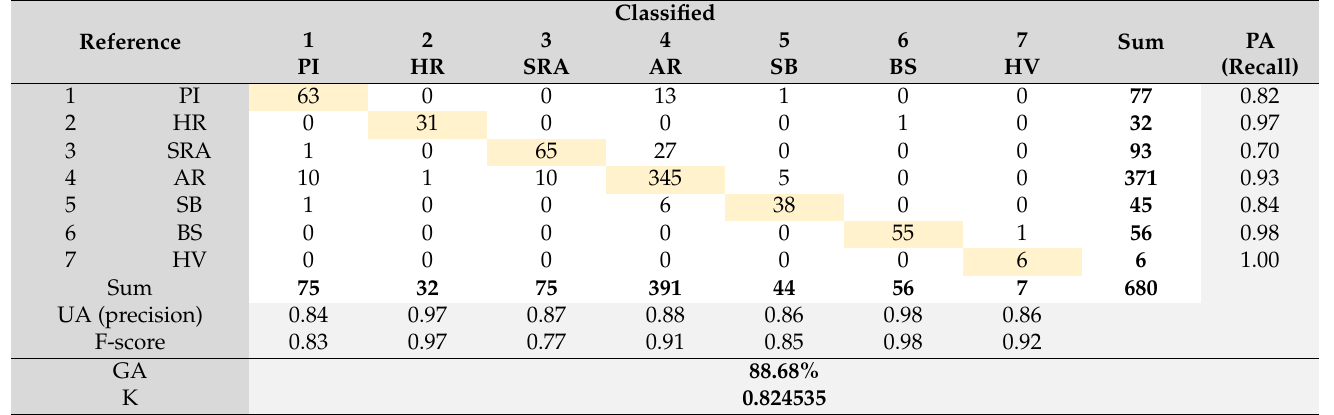
Table 11. Confusion classification matrix for the PNMDLC area. The rows represent the reference map, and the columns represent the classified map. The classes are 1— Pinus sp. (PI), 2—herbaceous restinga (HR), 3—shrub–arboreal restinga (SRA), 4—arboreal restinga (AR), 5—shade (SB), 6—bare soil (BS), and 7—herbaceous vegetation (HV). The table also includes the measures of producer accuracy or recall (AP), user accuracy or precision (AU), F-score, global accuracy (GA), and kappa Cohen index (K).